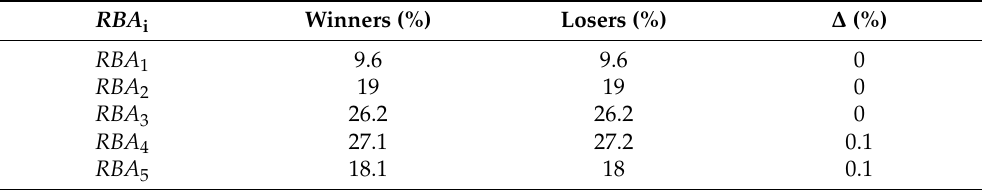
Table 1. Averages of RBA 1…5 values and their absolute differences ( Δ ) in percentage.